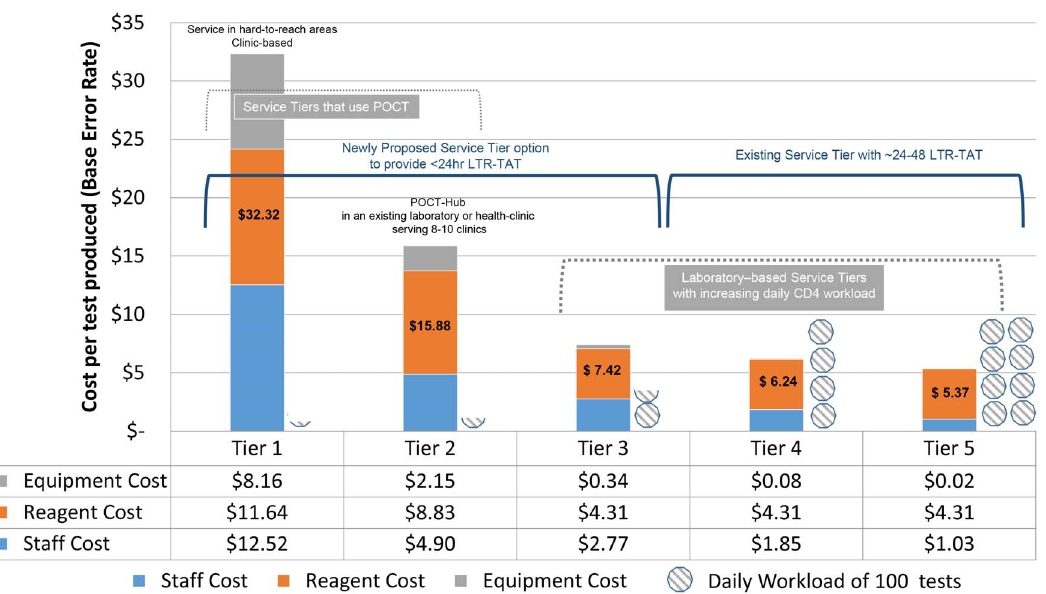
Fig. 1. Breakdown of costs. Breakdown of individual cost components, i.e. equipment, reagent and staff costs, used to derive cost per test, at baseline error rates per tier (12% for Tier-1; 8% for Tier-2 and 1% for Tiers 3–5). Daily workload is graphically represented. Existing (Tier-4 and Tier-5) and proposed tiers (Tier-1, or Tier-2 or Tier-3) is shown, as well as service tiers that use POC technologies to CD4 deliver